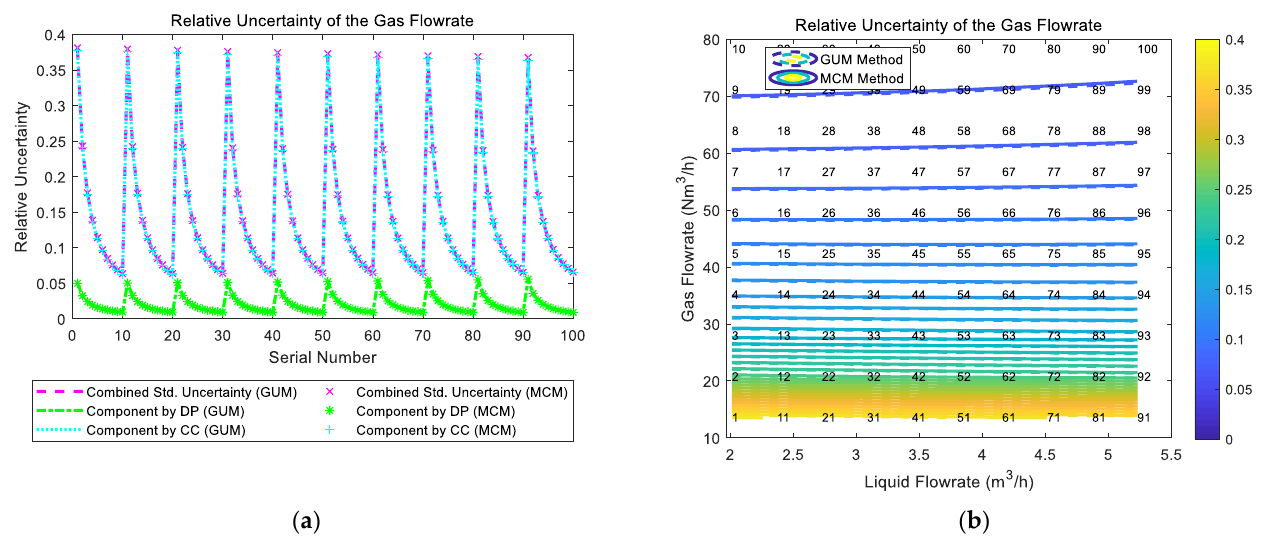
Figure 17. Composition and distribution of the relative uncertainty of the gas flowrate of the “CC + DP” method: ( a ) composition diagram; ( b ) distribution diagram. (Each contour line denotes an increment of uncertainty of 0.01. More information about the composition and distribution can be found in Section 2.4.1).